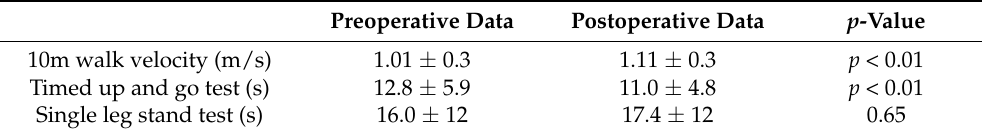
Table 3. Results of gait and posture balance